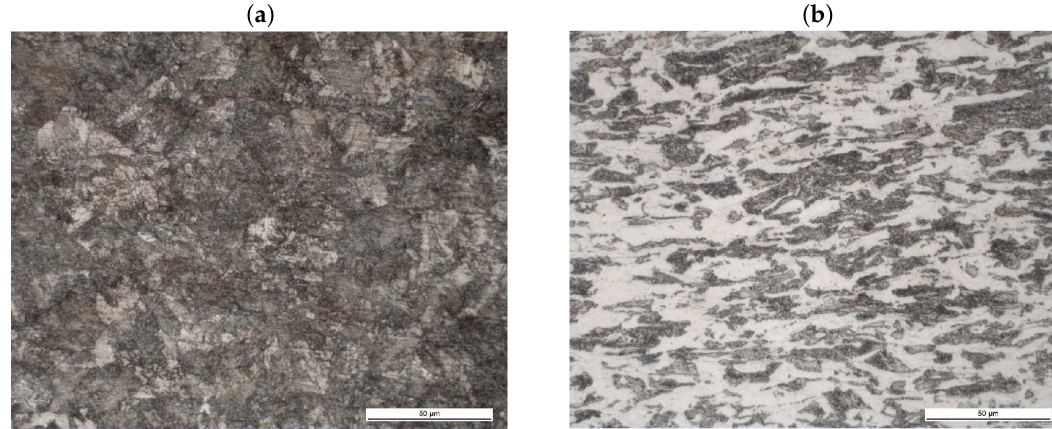
Figure 7. Microstructure of both materials in the longitudinal direction after testing. ( a ) Material 1 ( ε eng ≈ 0.15). ( b ) Material 2 ( ε eng ≈ 0.32).